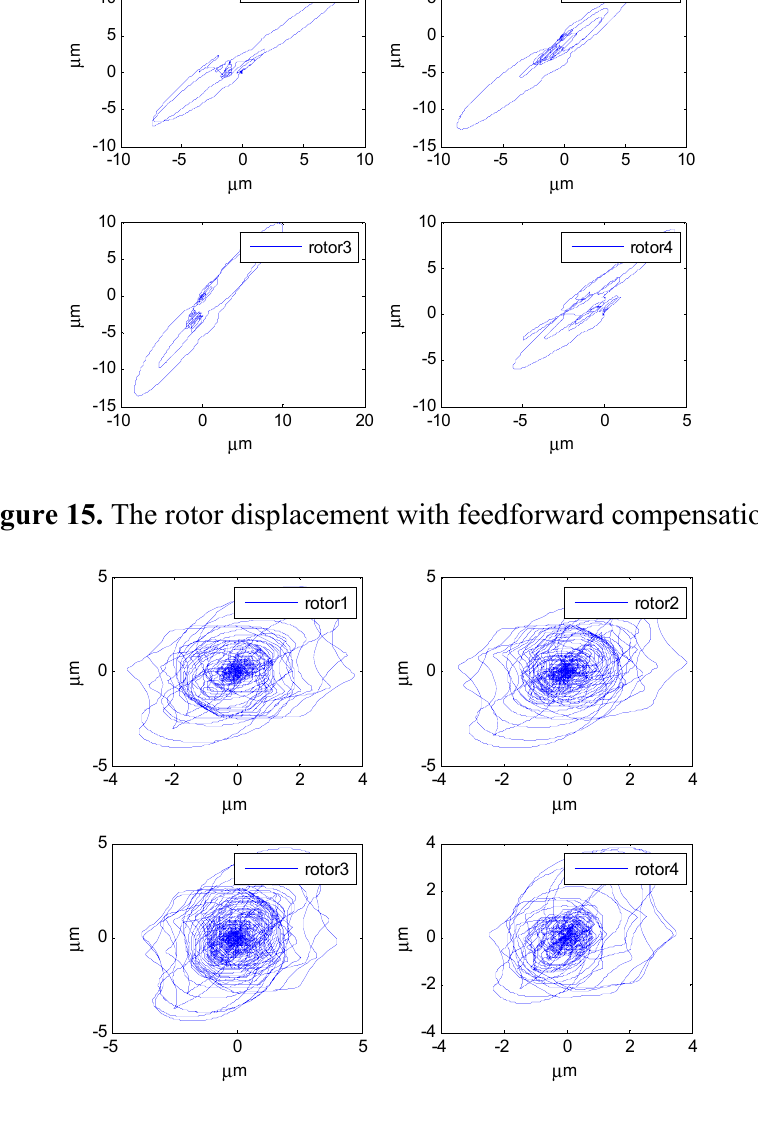
Figure 16. The magnitude of the rotor displacement without feedforward